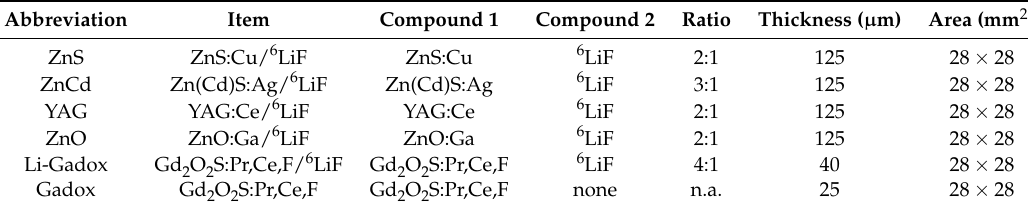
Table 1. Physical and chemical properties of the evaluated scintillation